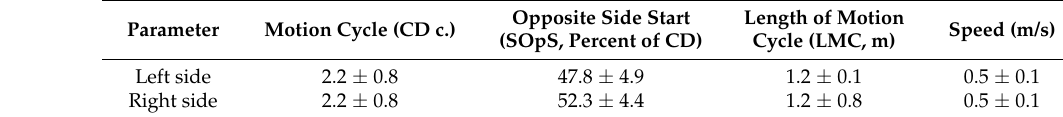
Table 1. Space–time parameters of the tested group, p > 0.05.